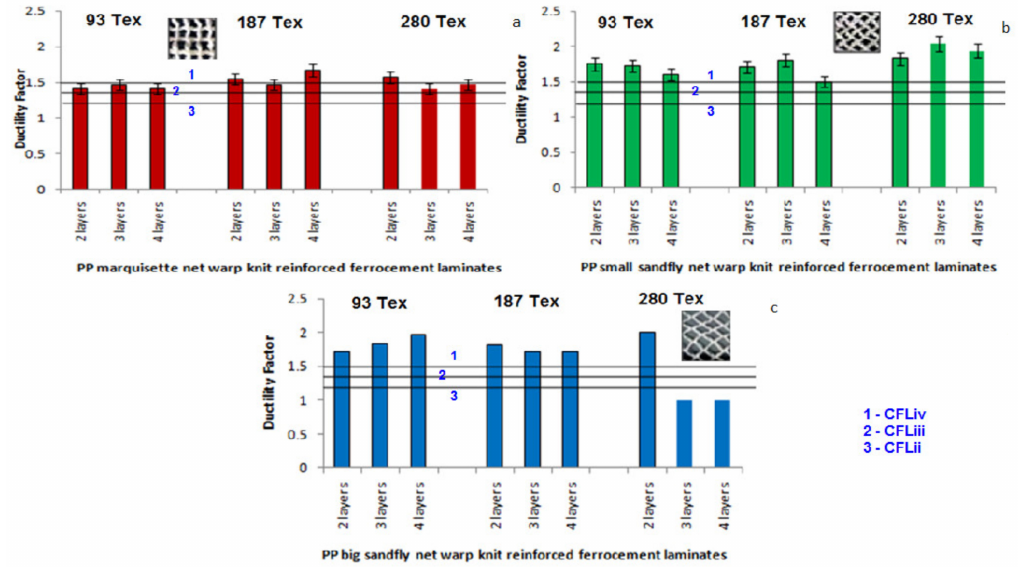
Figure 11. Ductility factor analysis of ( a ) marquisette, ( b ) small sandfly, and ( c ) big sandfly net polypropylene warp knitted reinforced ferrocement composites.